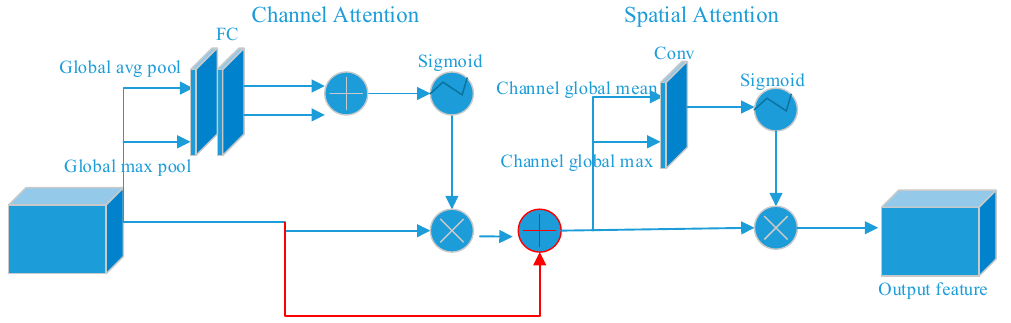
represents the final output of